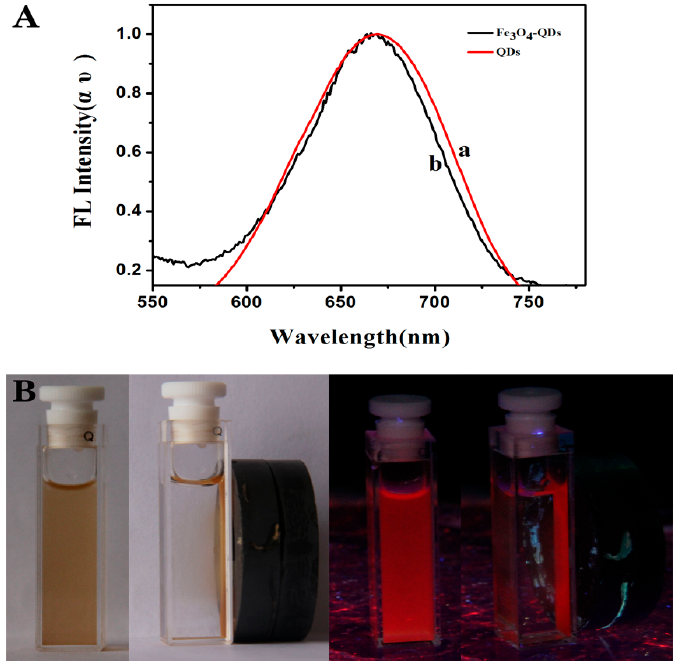
Figure 1. ( A ) the fluorescence spectra of CdTe/CdS QD (a) and the DMFN (b), and ( B ) the photograph of DMFN under white light ( left ) and UV light ( right ).